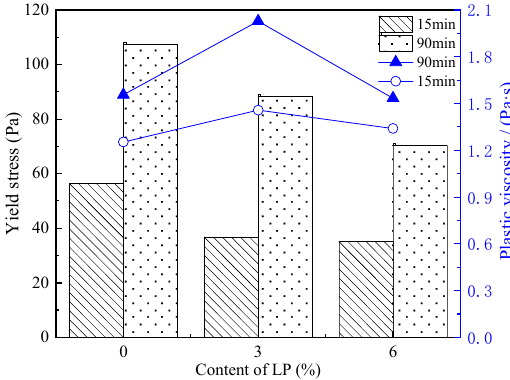
Figure 5. Yield stress and plastic viscosity of C-LP pastes.